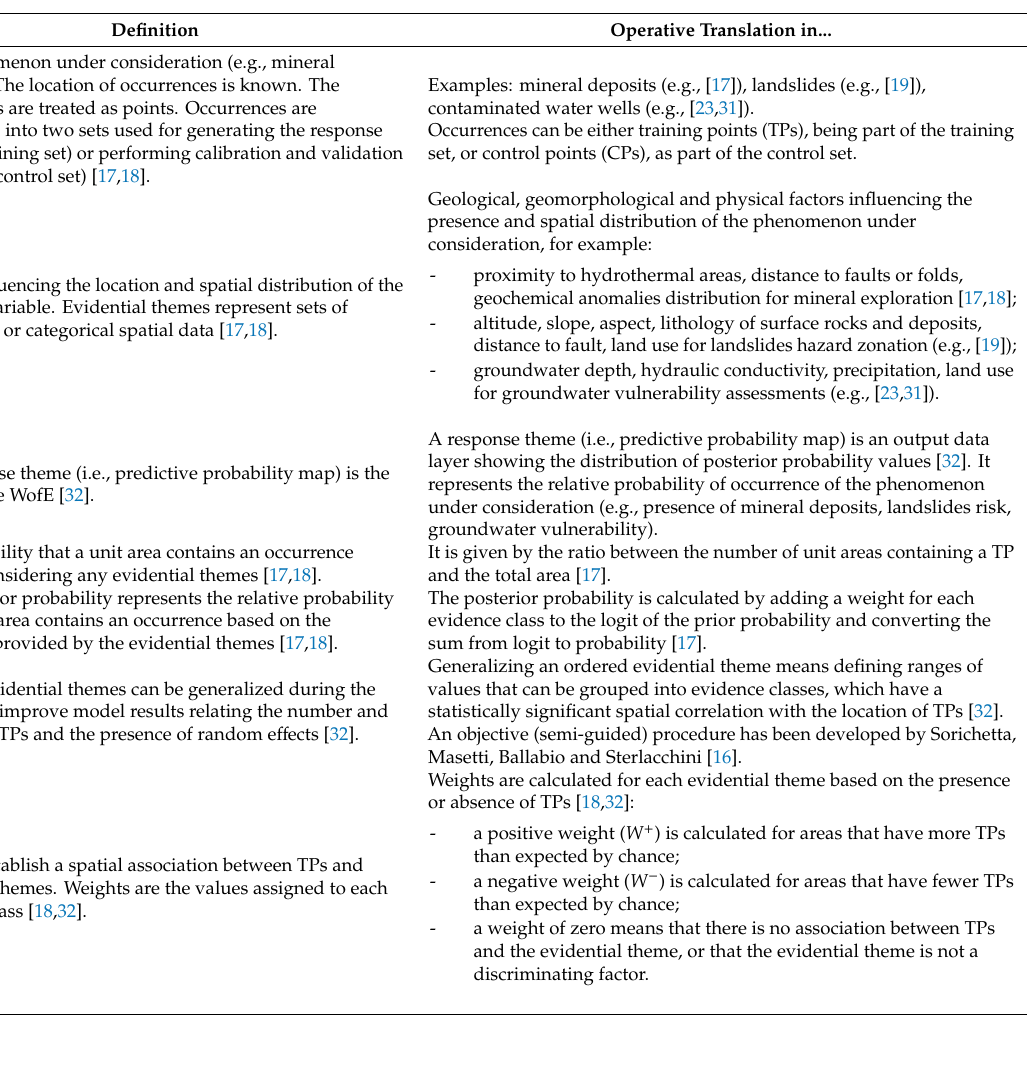
Table 1. Relevant concepts of the WofE technique and their operative applications in natural resources